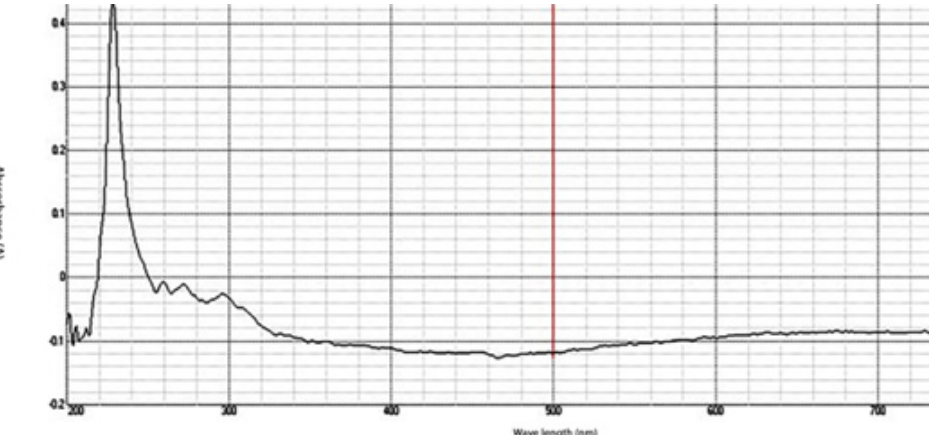
Figure 1. UV-Analysis- The absorption peak for Chitosan nanoparticles (CSNPs) in the range of 200–750 nm.